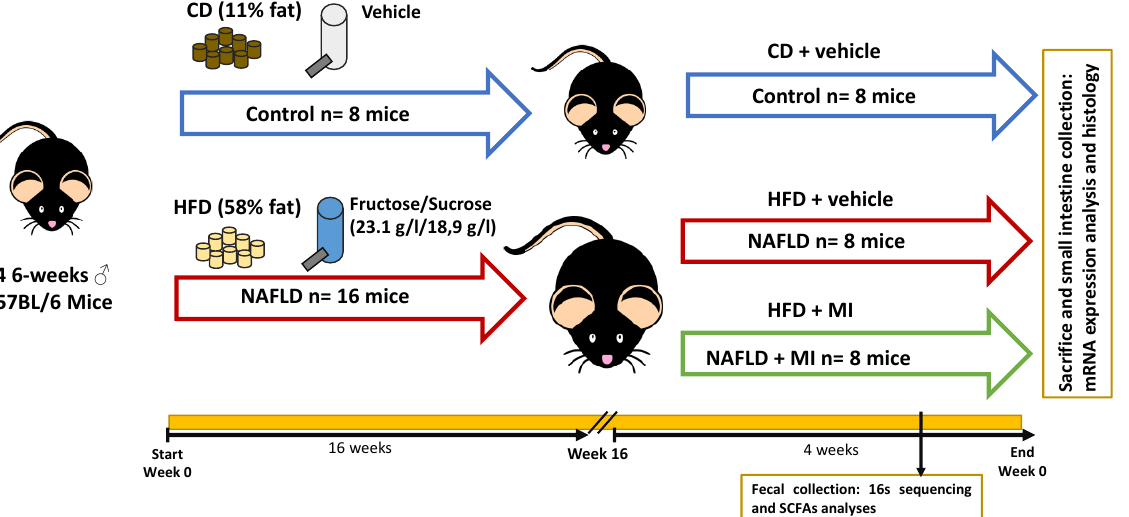
Figure 7. Schematic representation of the study design for the induction of NAFLD in mice (n = 24 animals; n = 8 control mice and n = 16 NAFLD mice), and the following treatment with MI supplementation in NAFLD mice for 4 weeks (n = 8 control mice, n = 8 NAFLD mice, and n = 8 NAFLD-MI mice). The variables analyzed in all study groups are represented. Abbreviations: CD, control-chow diet; HFD, high-fat diet; NAFLD, non-alcoholic fatty liver disease; SCFAS, short chain fatty acids.